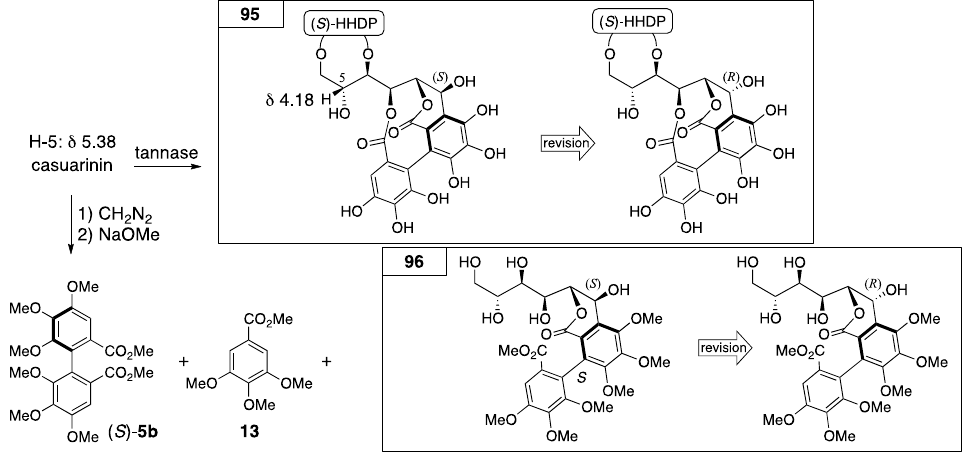
Figure 36. The transformations used for the determination of the first structure of casuarinin ((1 S )- 91 ).